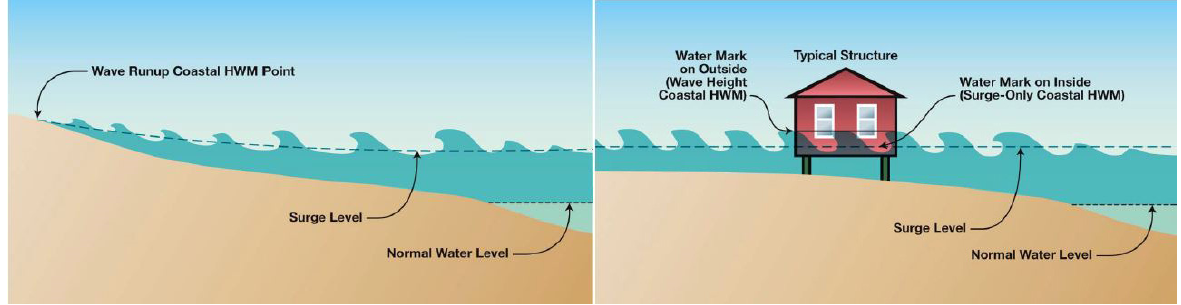
Figure 6. Types of high-water events (URS Group, 2006).